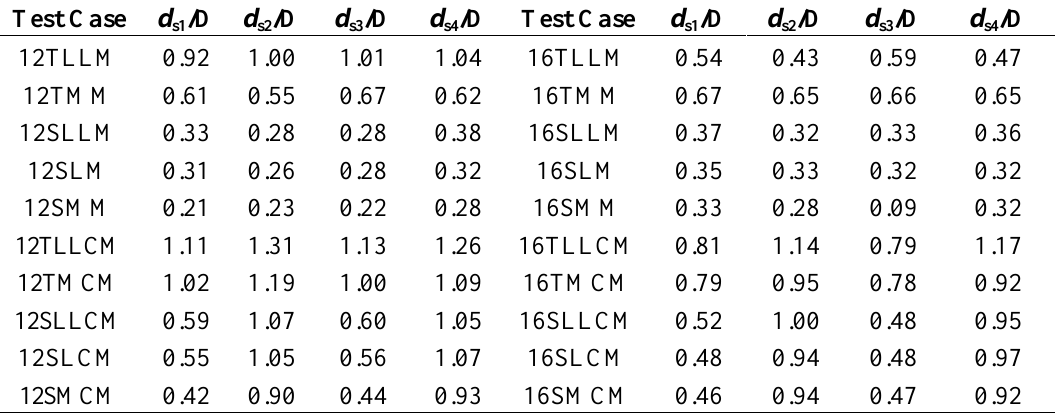
Table 2. Maximum scour depth around the four piles of the jacket-type foundation (a water depth of 12 m and 16 m) under different hydrodynamic conditions (pile diameter, D = 2.08